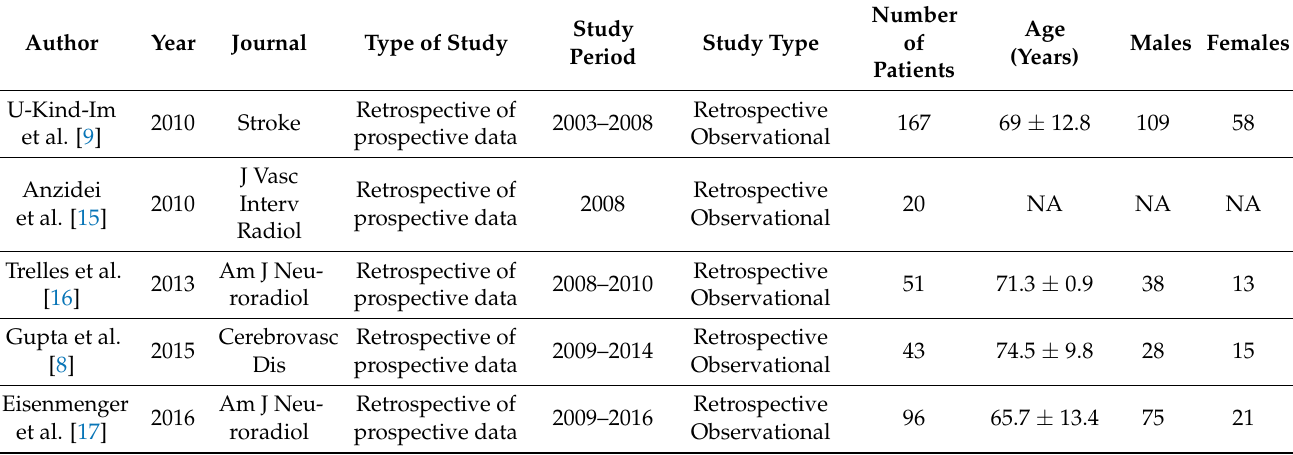
Table 1. Main study characteristics of the included studies.